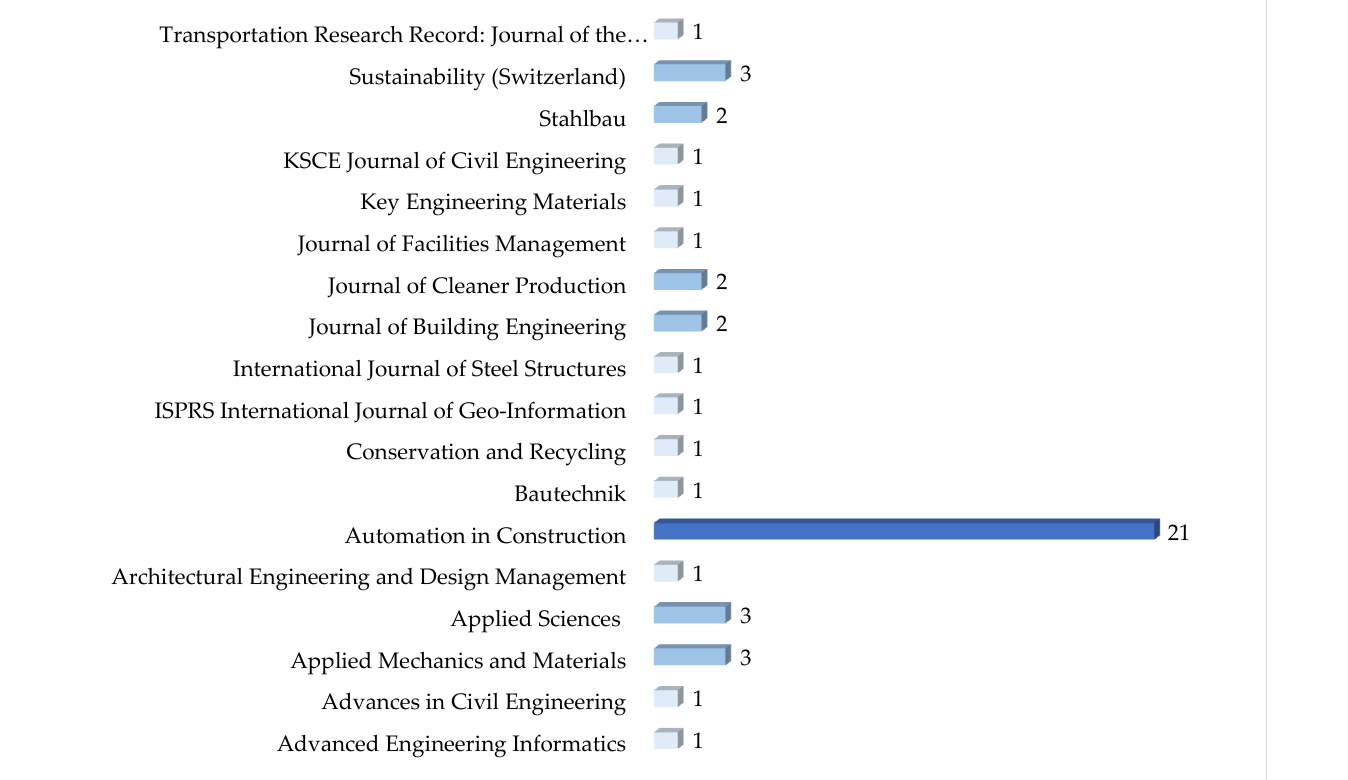
Figure 4. Number of publications per journal.